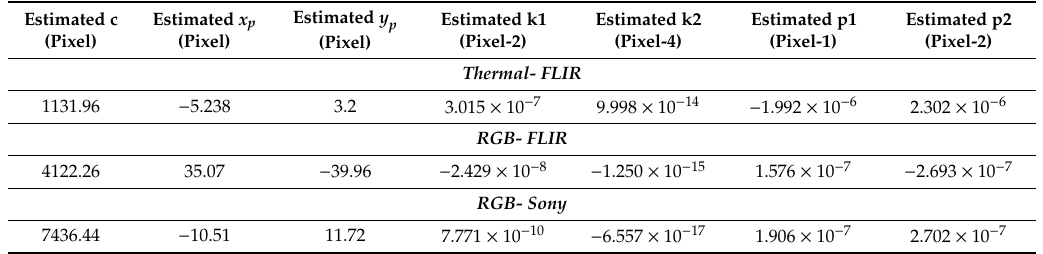
Table 4. Interior orientation parameters (IOPs) for the FLIR and Sony